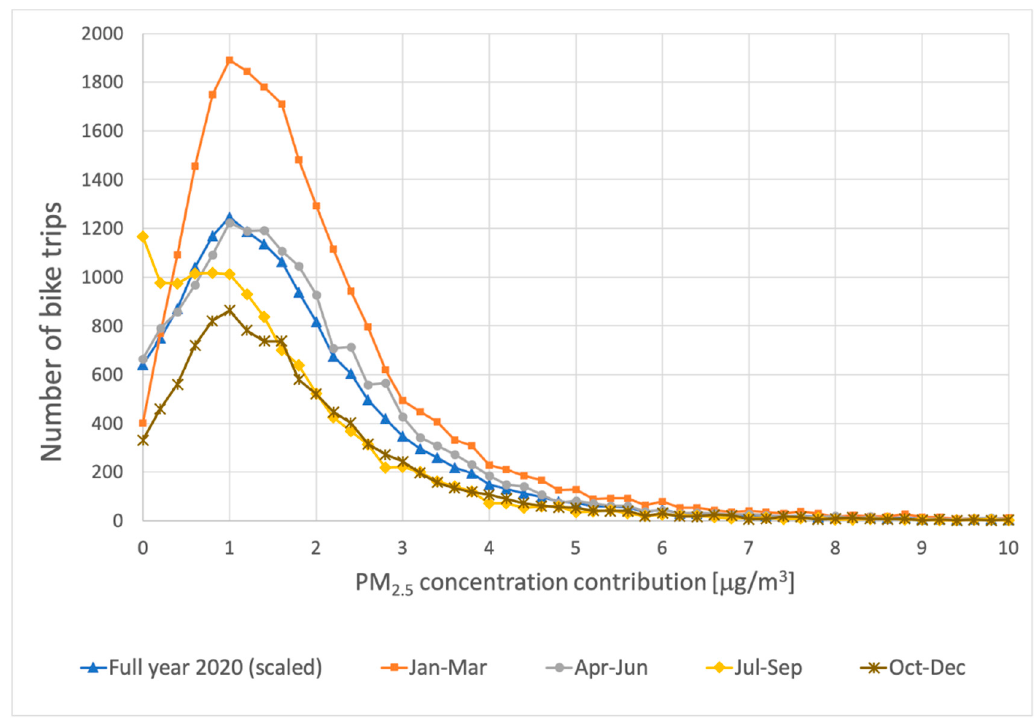
Figure 12. The number of times estimated PM2.5 contributions due to road traffic were measured by the bicycles, for different parts of the year. “Full year 2020 (scaled)”: estimated contributions due to road traffic using the 0.10 percentile of bike measurements as an assumed background and excluding hours with relatively fast changing global background in the province. In order to make the curves easier to compare, the results for the whole of 2020 have been scaled down to 25%. The curves “January–March”, “April–June”, “July–September”, and “October–December” are obtained using data from those months in 2020 only.